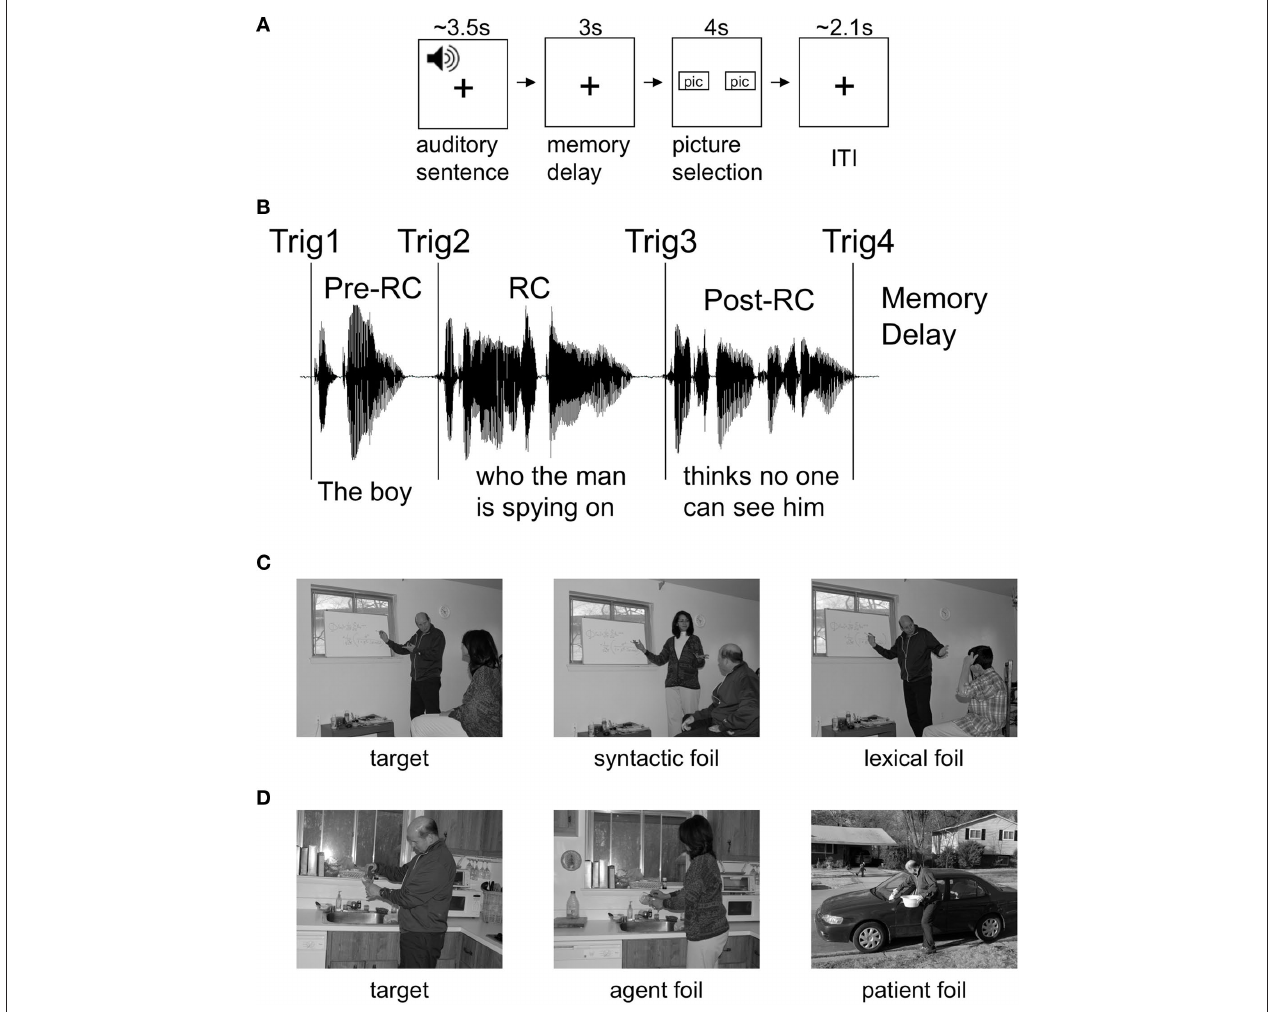
FiguRE 1 | Task design. (A) Schematic illustration of trial structure. On each trial, subjects heard a sentence while viewing a fixation cross. After a 3-s delay, two pictures appeared, the target and a foil. (B) Illustration of the placement of digital triggers within the sound files of individual sentences, to allow analysis of EEG–MEG data timelocked to specific points within and following the